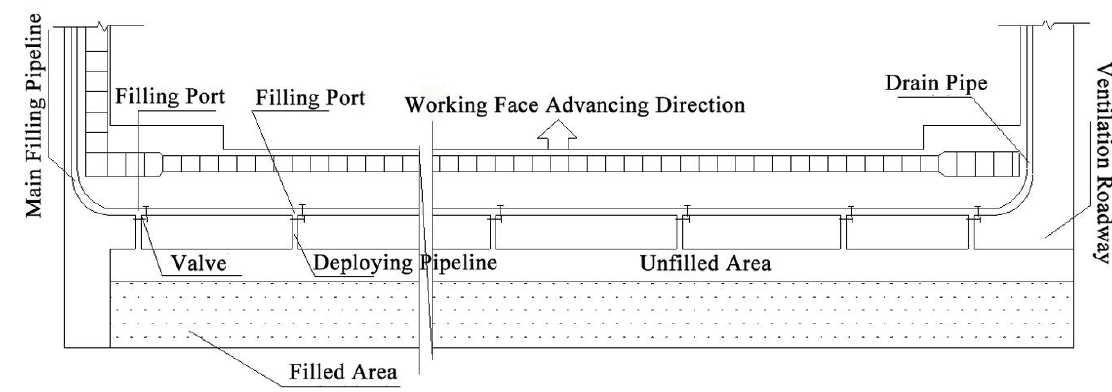
Figure 16. Layout diagram of the filling face.